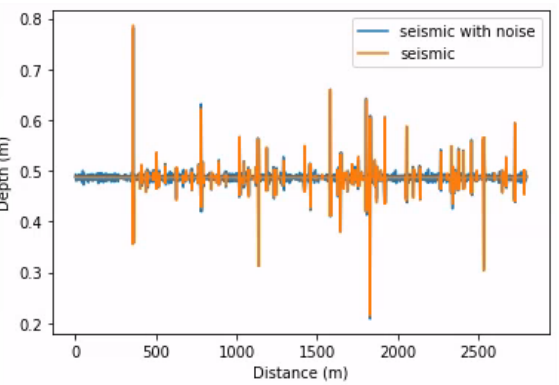
Figure 8. Two acoustic seismic traces, one with noise and the other without, stacked together.